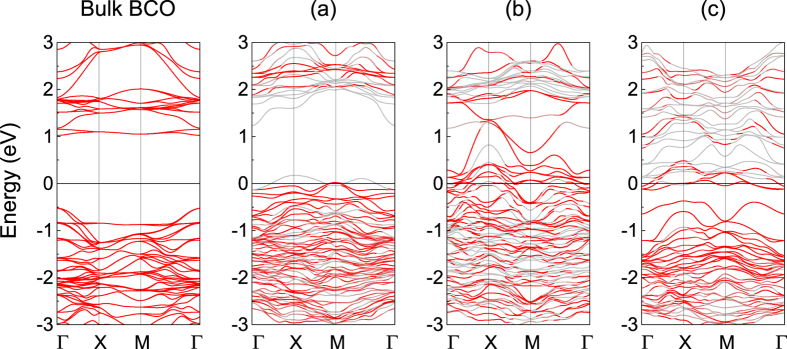
Spin-up band structure of bulk BCO, model (a) CoO2-BiO, (b) CoO2-FeO2 and (c) BiO-FeO2 bilayers. The red color indicates BCO and gray BFO. EF = 0 eV.